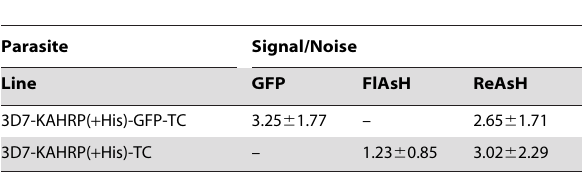
Table 1. S/N ratios of GFP, FlAsH and ReAsH fluorescence from 3D7-KAHRP( + His)-GFP-TC- and 3D7-KAHRP( + His)-TC- transformed PE.